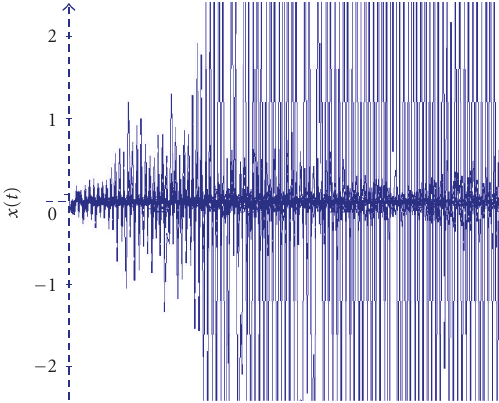
Figure 7.4 . Unstable solution of (5.2) in the point Z (510,100), a 0 = 0 . 1.